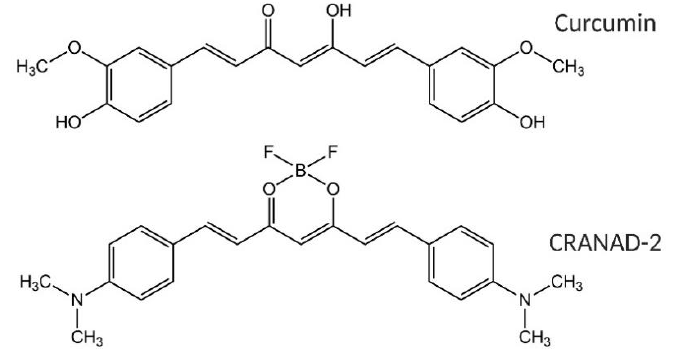
Figure 1. (Top) Structure of curcumin and (bottom) structure of CRANAD-2 .